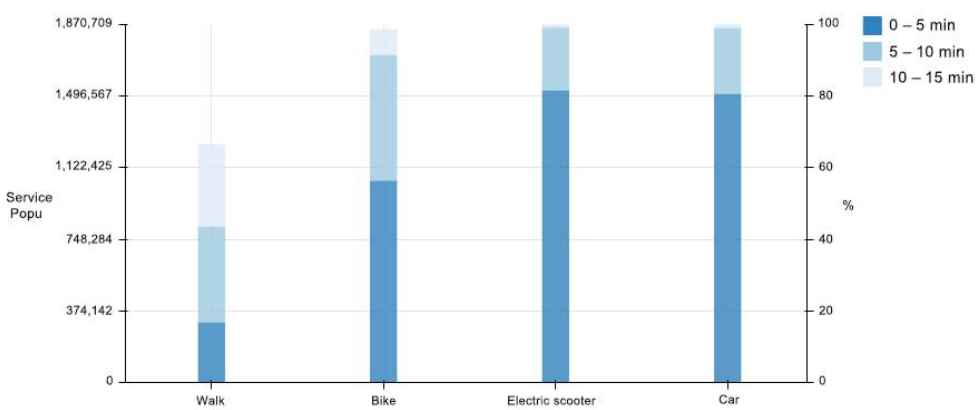
Figure 4. Service population of the community healthcare centers of four travel modes. The average and median walking time from communities to the nearby